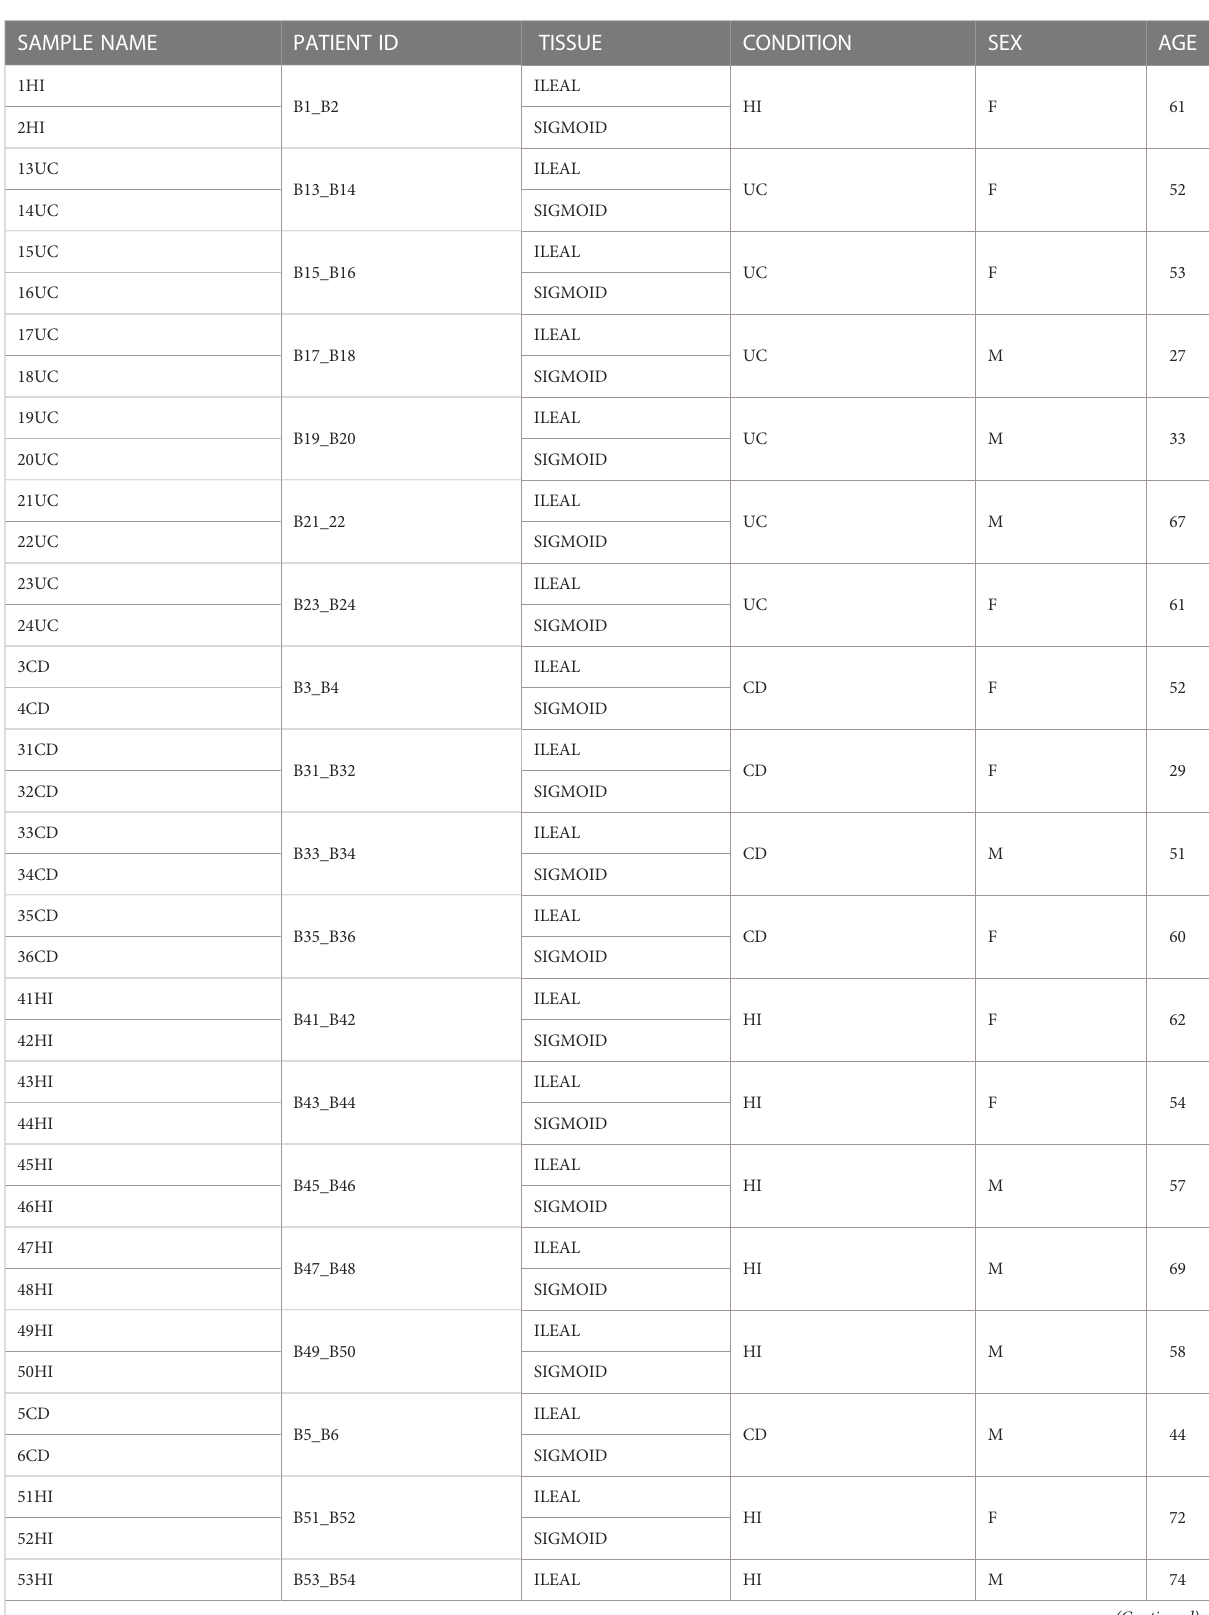
TABLE 1 Demographic characteristics of included